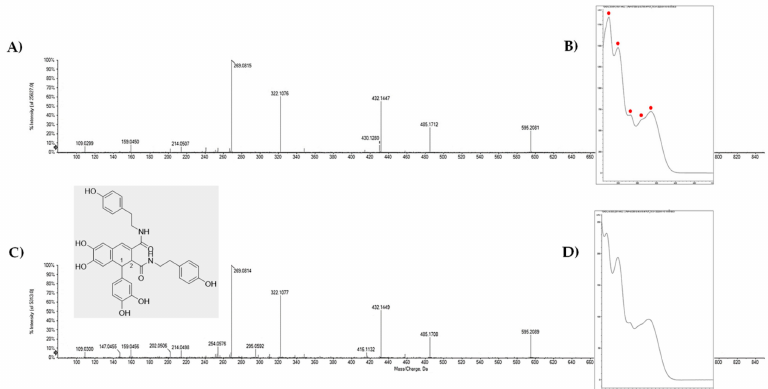
Figure 3. TOF-MS / MS spectra of compounds 15 and 22 ( A and C , respectively). UV-DAD spectra of the compounds ( B and D ). In grey panel, the structure of cannabisin B is reported, without emphasizing stereochemical